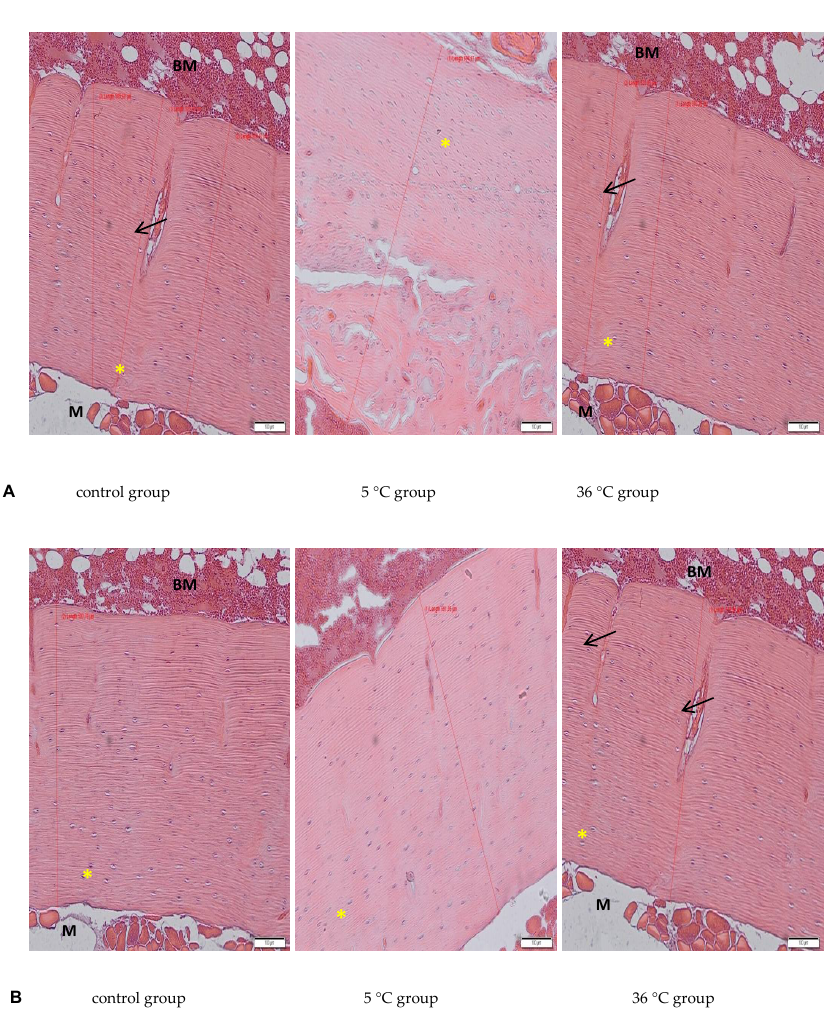
Figure 5. Histological analysis of the bones of female ( A ) and male ( B ) rats from control and test groups. Rats were subjected to 4 min swimming sessions for 9 weeks in either cold water at 5 °C or at a thermally comfortable temperature of 36 °C. The first swimming session was 2 min long (day one) increasing by 0.5 min per day to 4 min (day five of the first week). Examination revealed a thicker layer of cortical bone in the rats swimming in cold water. HE staining, M—skeletal muscle tissue, BM—bone marrow; yellow asterisk—osteocytes in lacunae, black arrow—transverse channels in bone with blood vessels; ×10 objective magnification, original scale bar 100 µm, diameters of cortical bone measured in Olympus microscope software CellSense (Olympus, Warsaw, Poland), showed in µm scale. Only representative images are presented.